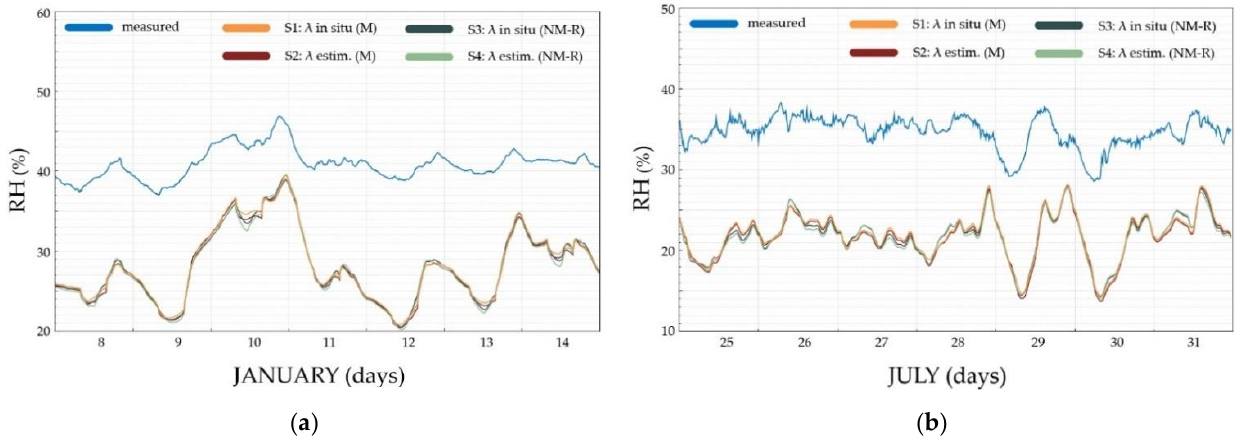
Figure 5. Relative Humidity (RH, %). Measured values vs. simulations: ( a ) 8 – 14 January 2018 ( b ) 25 – 31 July 2018